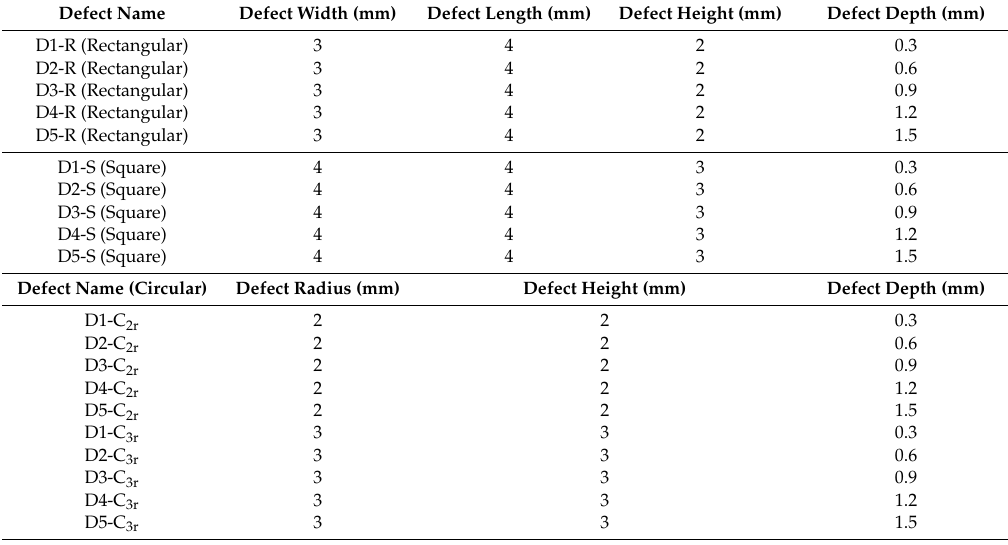
Table 1. Descriptions of the 20 different defects employed to test the impact of varying factors on IRT detectability .